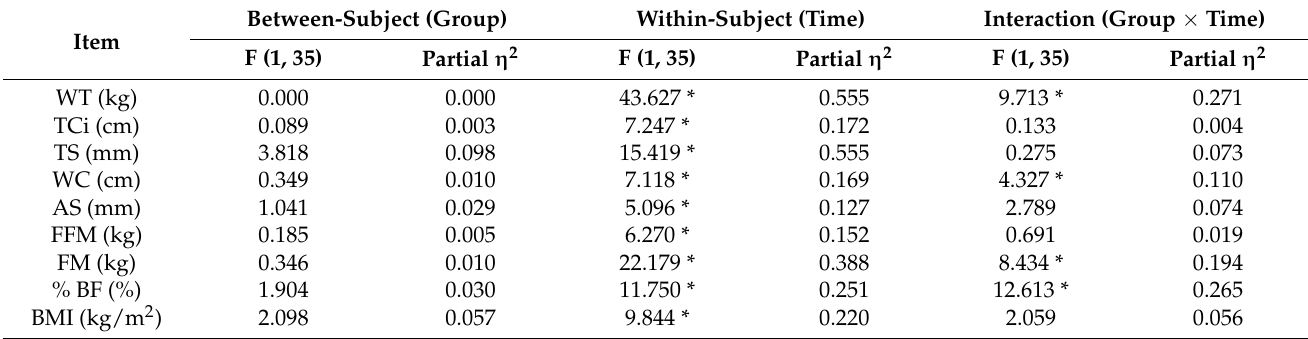
Table 2. The influence of different interventions on body composition (two-way ANOVA).